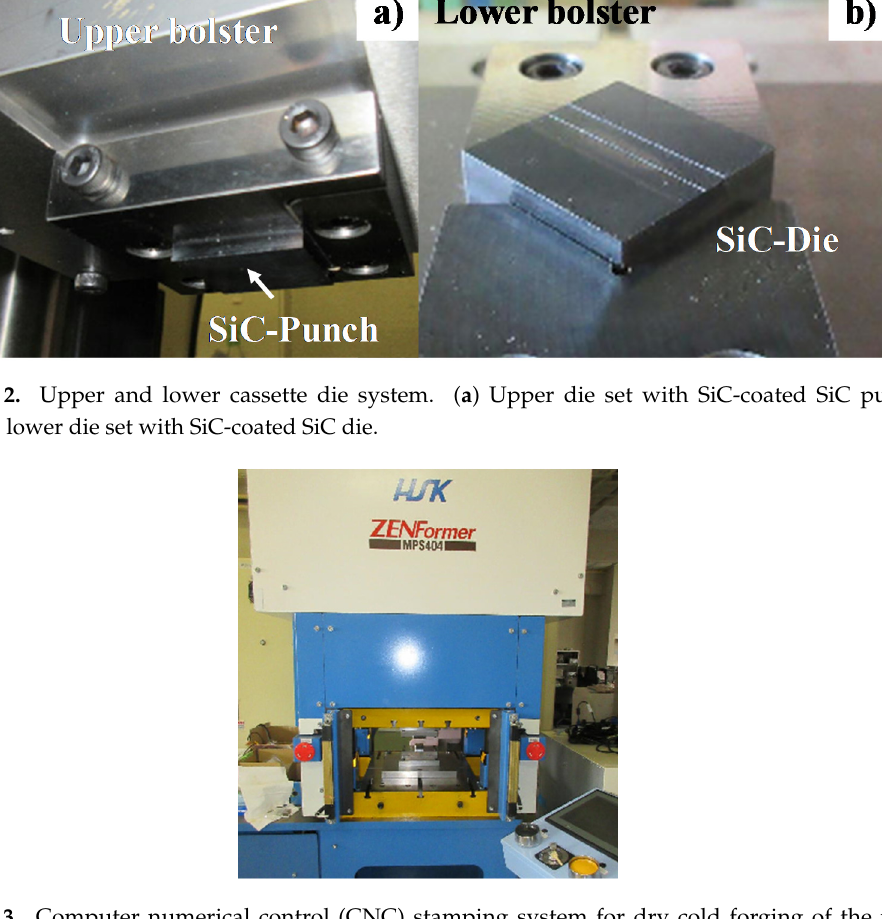
Figure 3. Computer numerical control (CNC) stamping system for dry cold forging of the pure titanium wire.